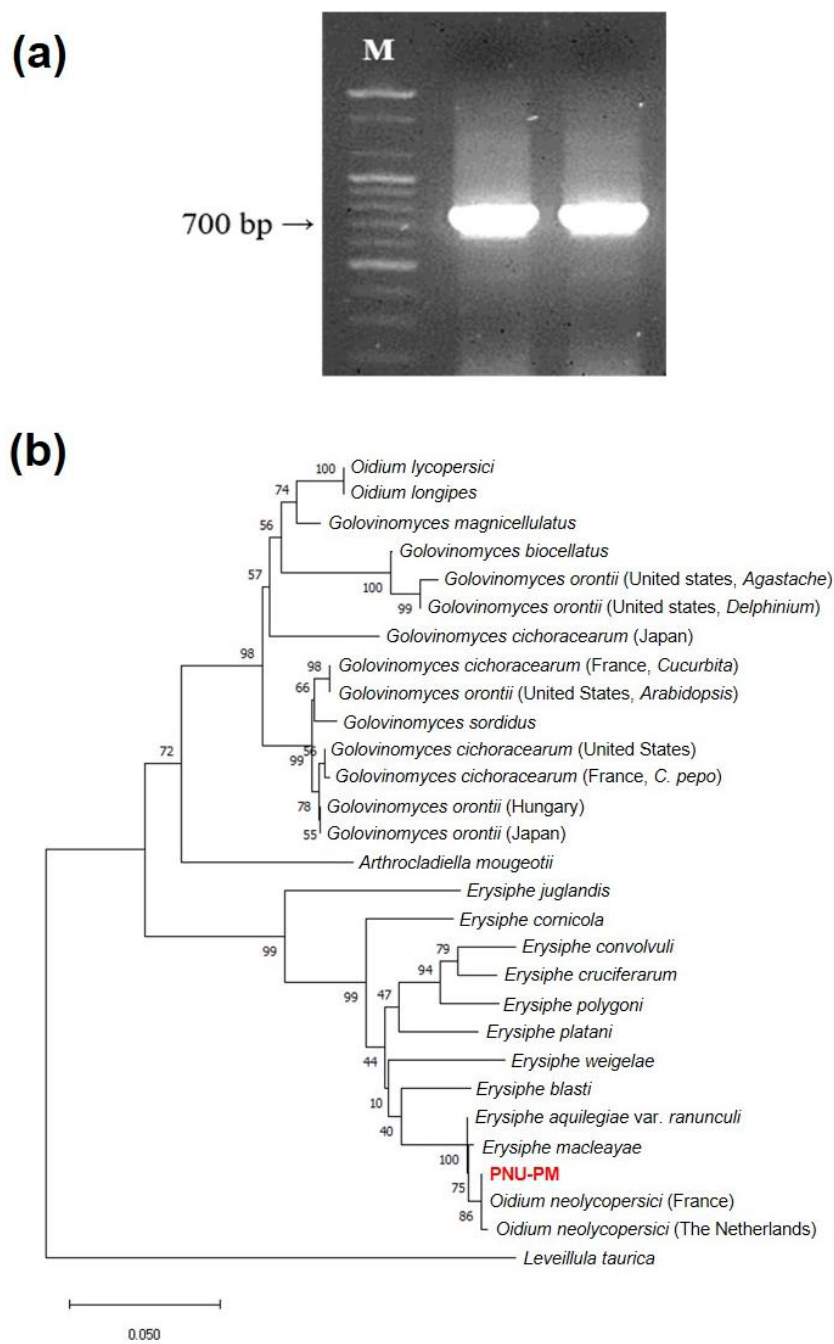
Figure 1. ( a ) Polymerase chain reaction (PCR) amplification of the internal transcribed spacer (ITS) region of the Oidium neolycopersici isolate ‘PNU-PM’ using the PMITS1 and PMITS2 primers [24]; ( b ) A phylogenetic tree of powdery mildew pathogens constructed using the neighbor-joining method based on the ITS sequences of ribosomal DNA. The duplicate PCR amplicons were loaded on an agarose gel, and the specificity of the ITS region of ‘PNU-PM’ was confirmed based on the size (700 bp) of the PCR amplicons. Lane ‘M’, 100 bp DNA size marker. The ITS of the ‘PNU-PM’ powdery mildew pathogen (red in b ) isolated in this study was found to be identical to that of O. neolycopersici.